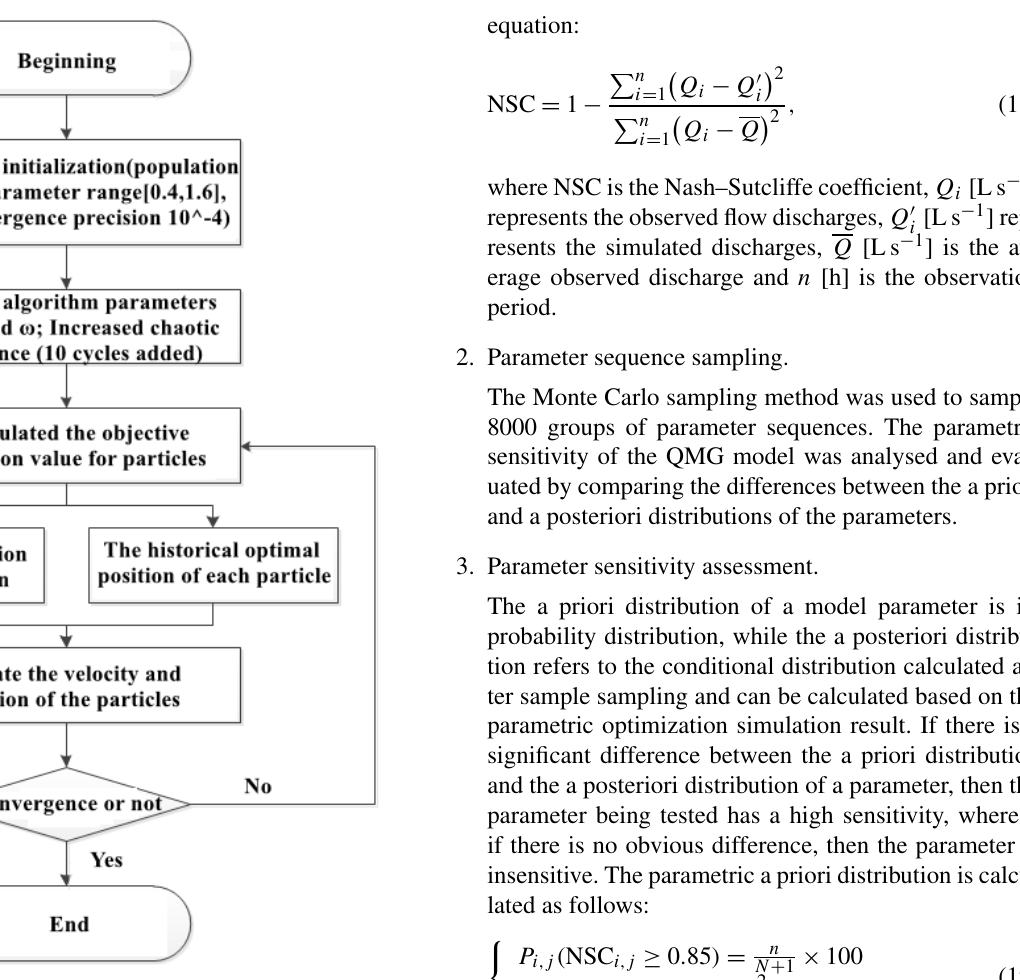
Figure 4. Algorithm flow chart of the improved chaotic particle swarm optimization